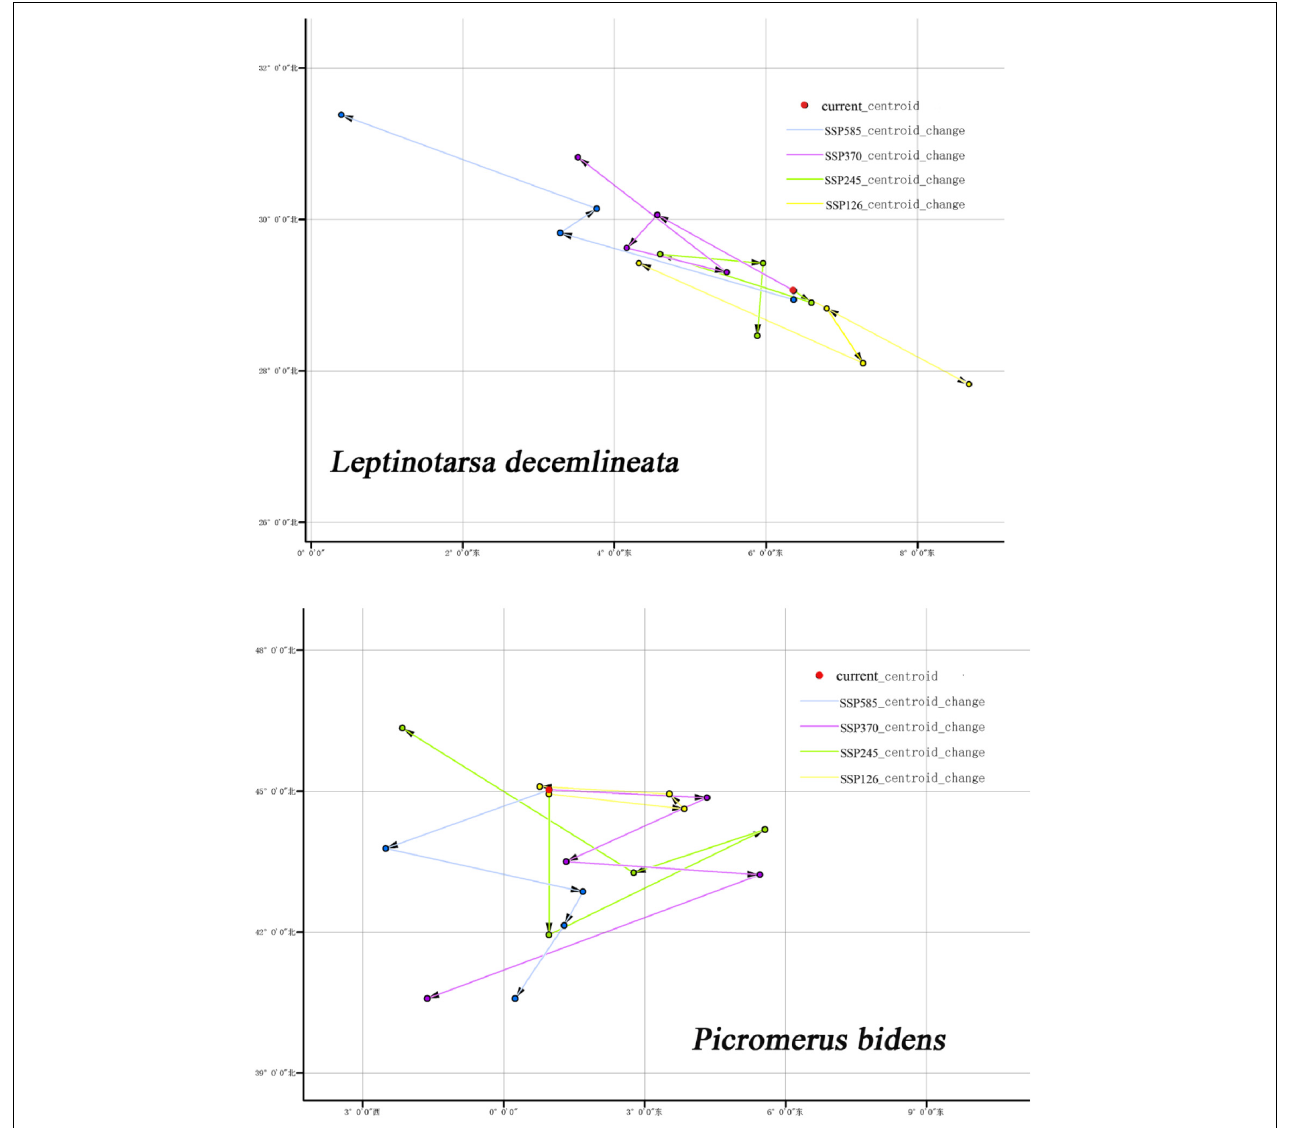
FIGURE 12 | Centroids movement of CPB and P. bidens in suitable distribution area under future climate scenarios.